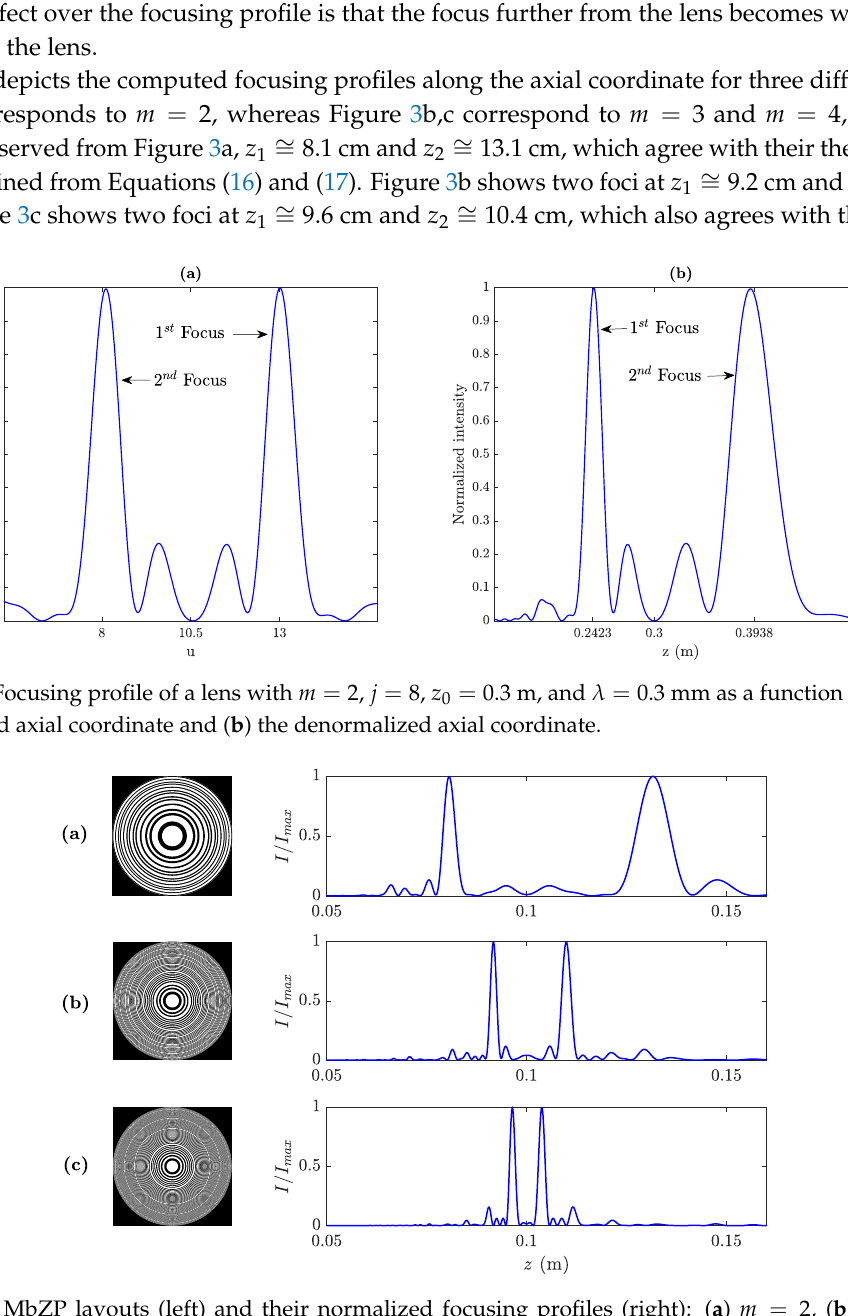
Figure 3. MbZP layouts (left) and their normalized focusing profiles (right): ( a ) m = 2, ( b ) m = 3, and ( c ) m = 4. For all MbZPs, j = 9 and z 0 = 0.1